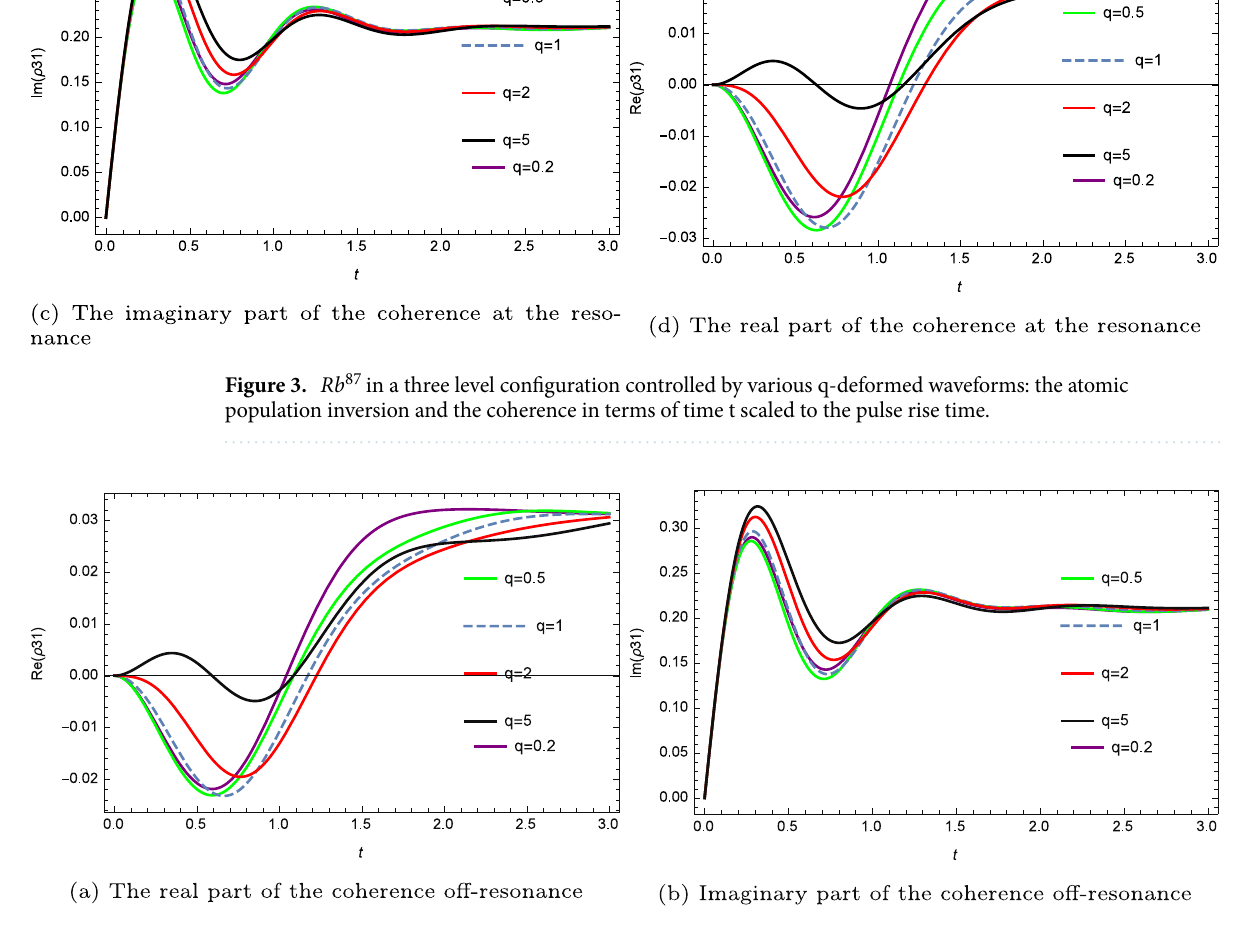
Figure 4. The real and the imaginary part of the coherence off-resonance and for various